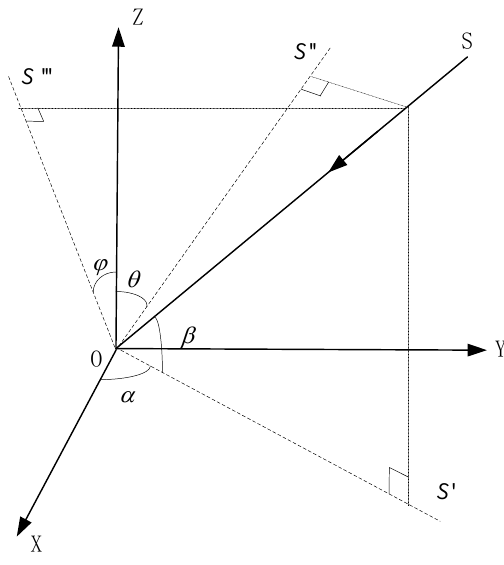
Figure 3. Model of incident